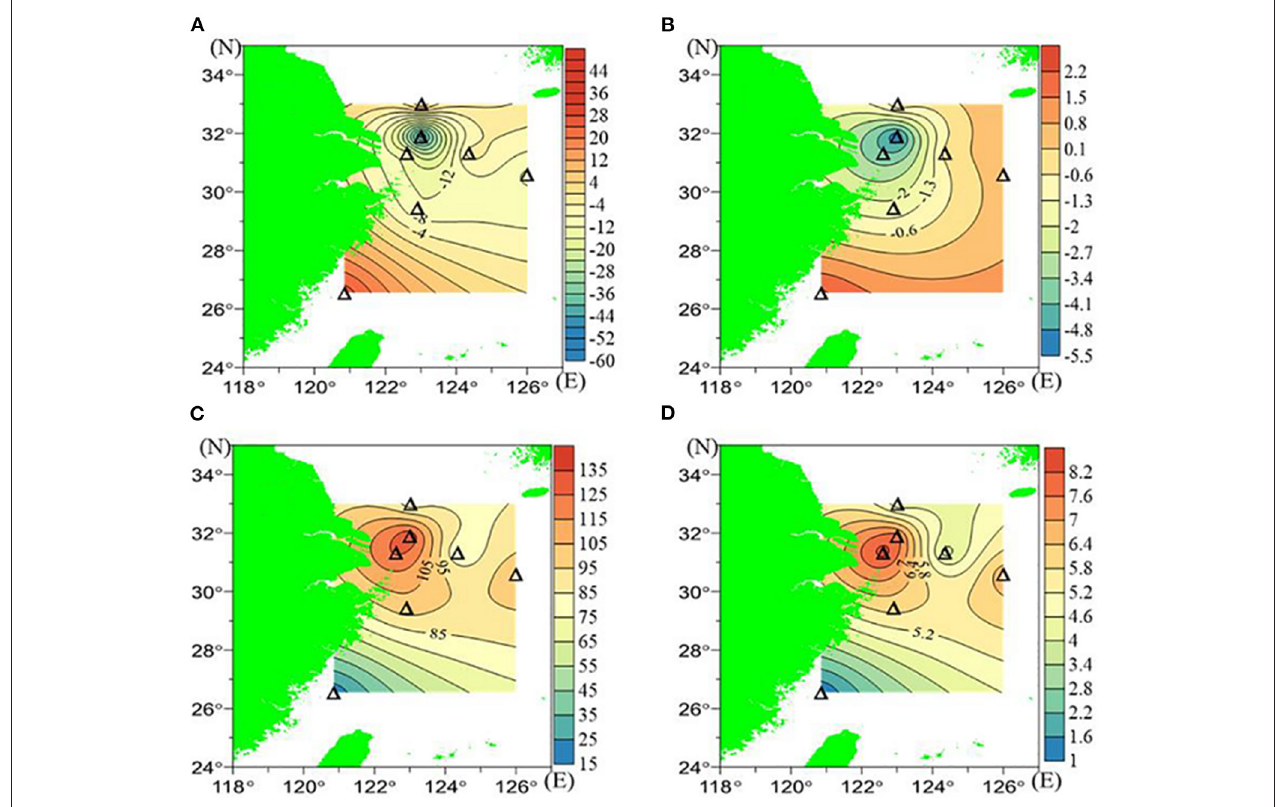
FIGURE 4 | The AOU and δ 18 O in July 2018: (A) surface AOU ( µ mol/L), (B) surface δ 18 O ( ‰ ), (C) bottom AOU ( µ mol/L), and (D) bottom δ 18 O ( ‰